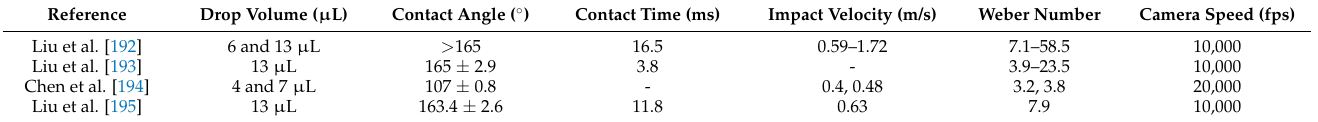
Table 2. List of typical experimental parameters used in drop impact